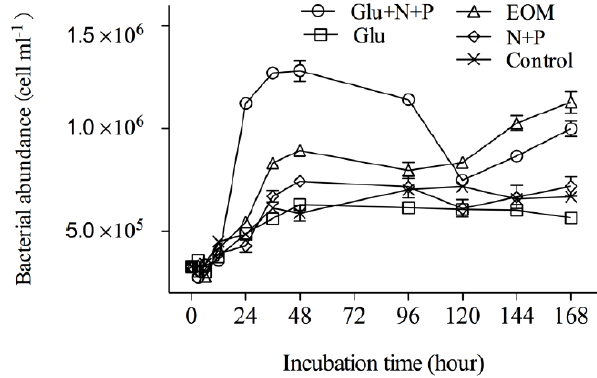
Figure 1. Variations of bacterial abundance during the incubation time course in various treatments. Error bars indicate the standard